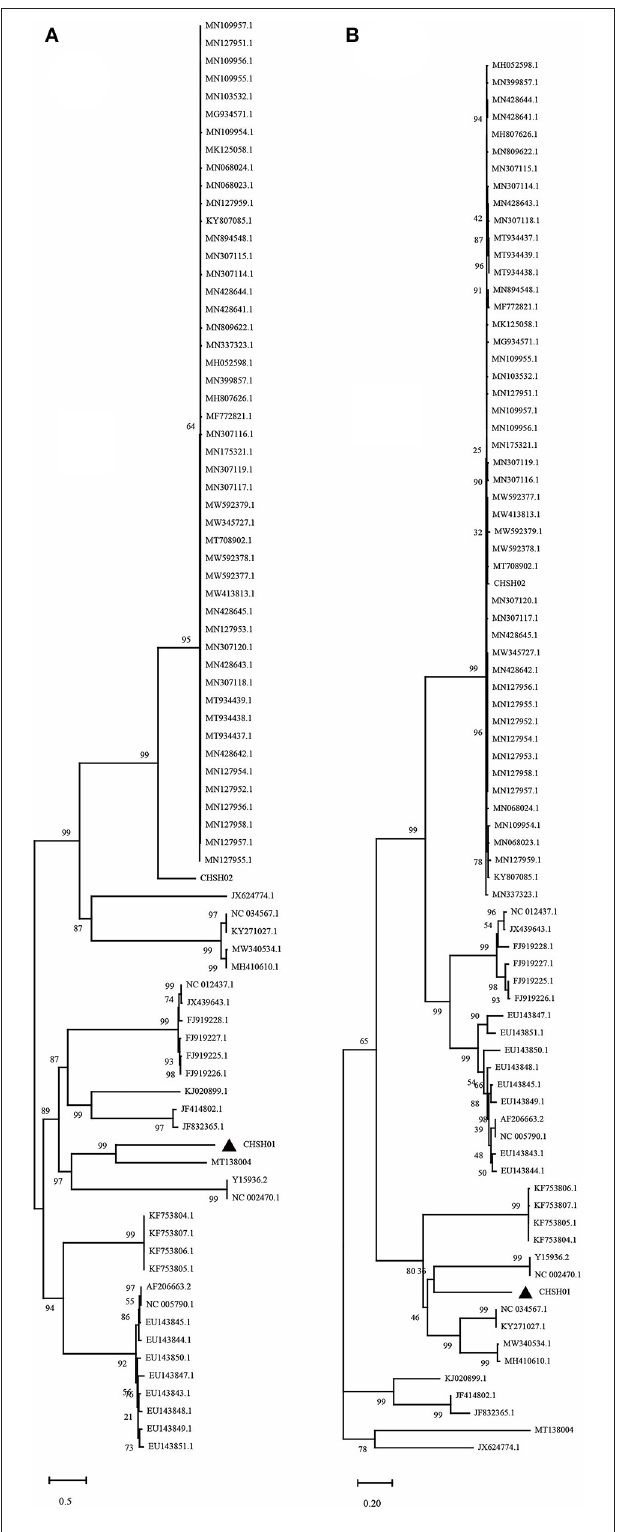
FIGURE 5 | Phylogenetic analysis of CHSH01 recombination. Two different phylogenetic trees based on the sequences before the breakpoint (1–5,992 nt) (A) and the exchange part (5,993–6,845 nt) (B) confirmed the recombination event.